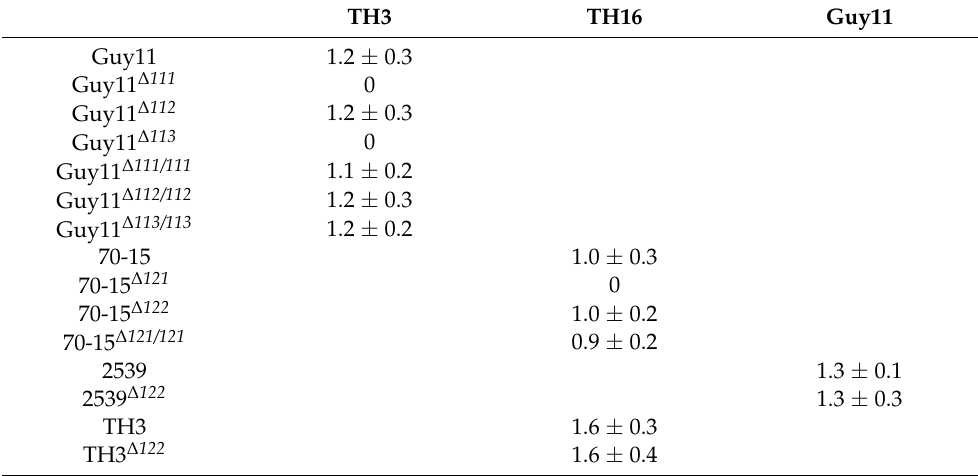
Table 2. The numbers of perithecia formed in the cross of MAT genes mutants, complement strains and the wild-type strains on OMA ( × 10 4